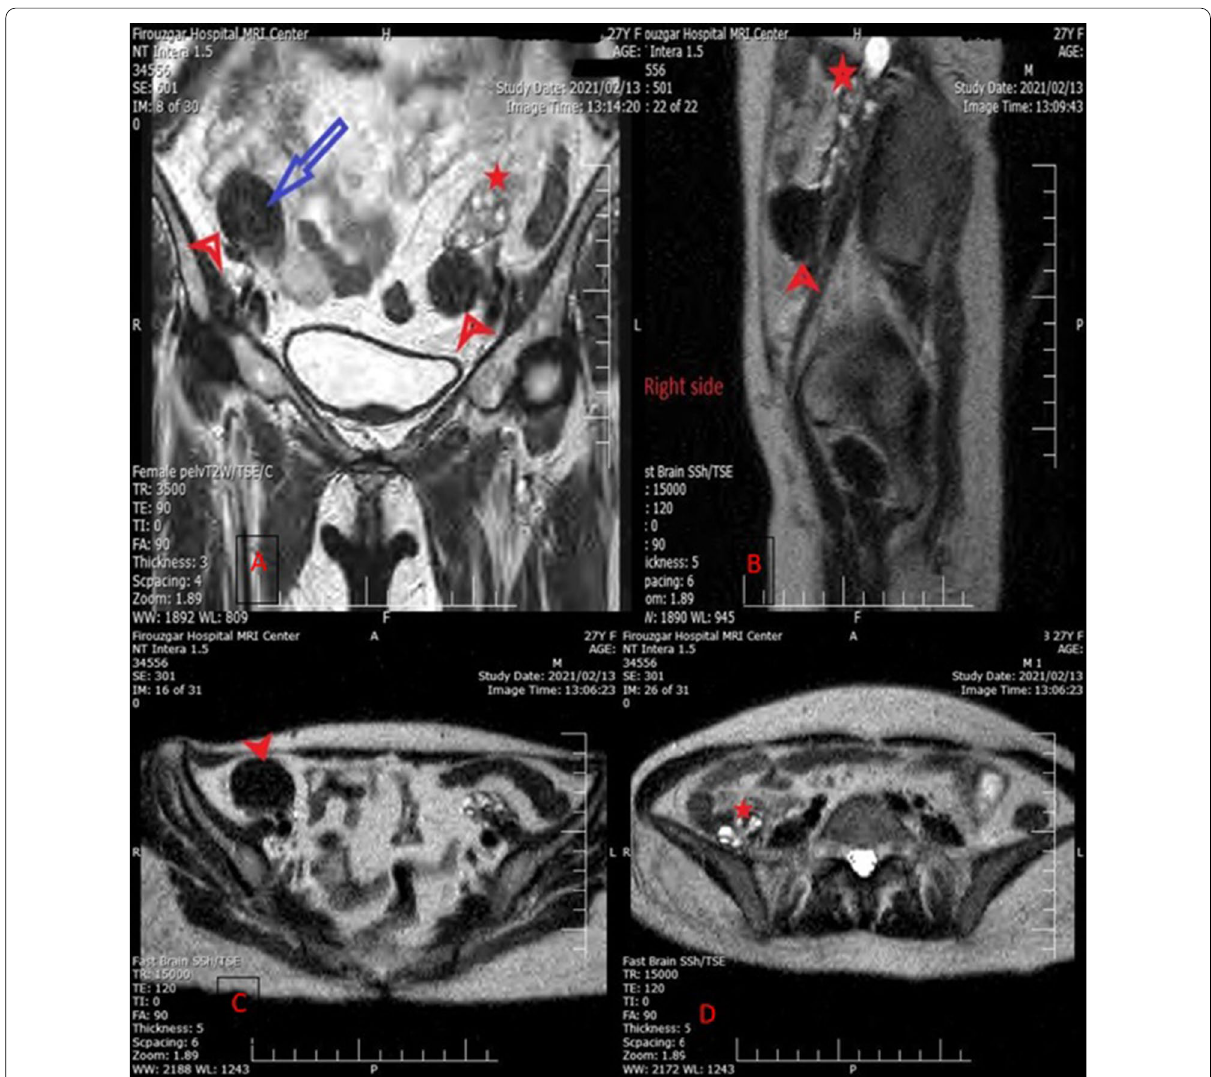
bifurcation with linear high signal endometrial component (blue arrow) in favor of completely separate uterus with separate hypoplastic cervix, Sagittal and axial T2‑weighted images in ( b , d ) show retroperitoneal structure with a few intralesional cystic components with morphology similar to right ovary (*) in L5‑S1 level, c right horn of didelphis uterus is shown in axial view (red arrow